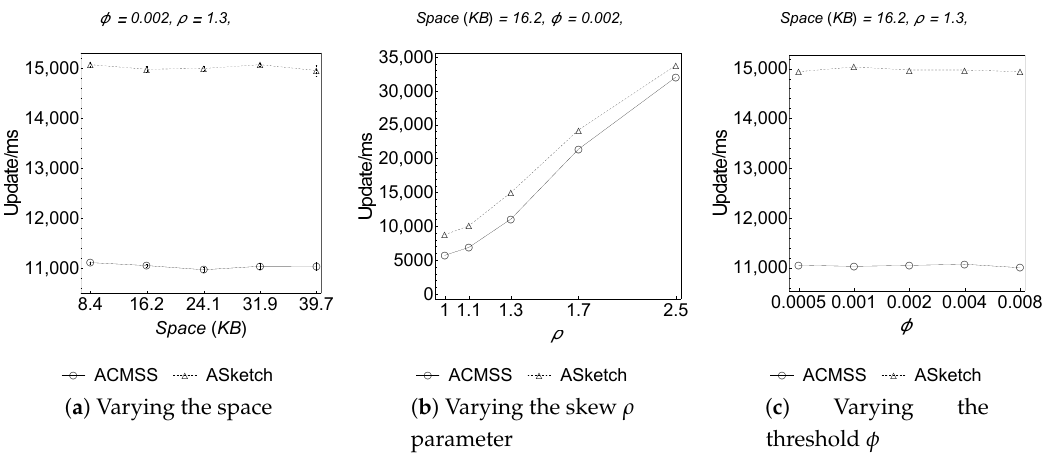
Figure 1. Efficiency of the algorithms: Stream processing